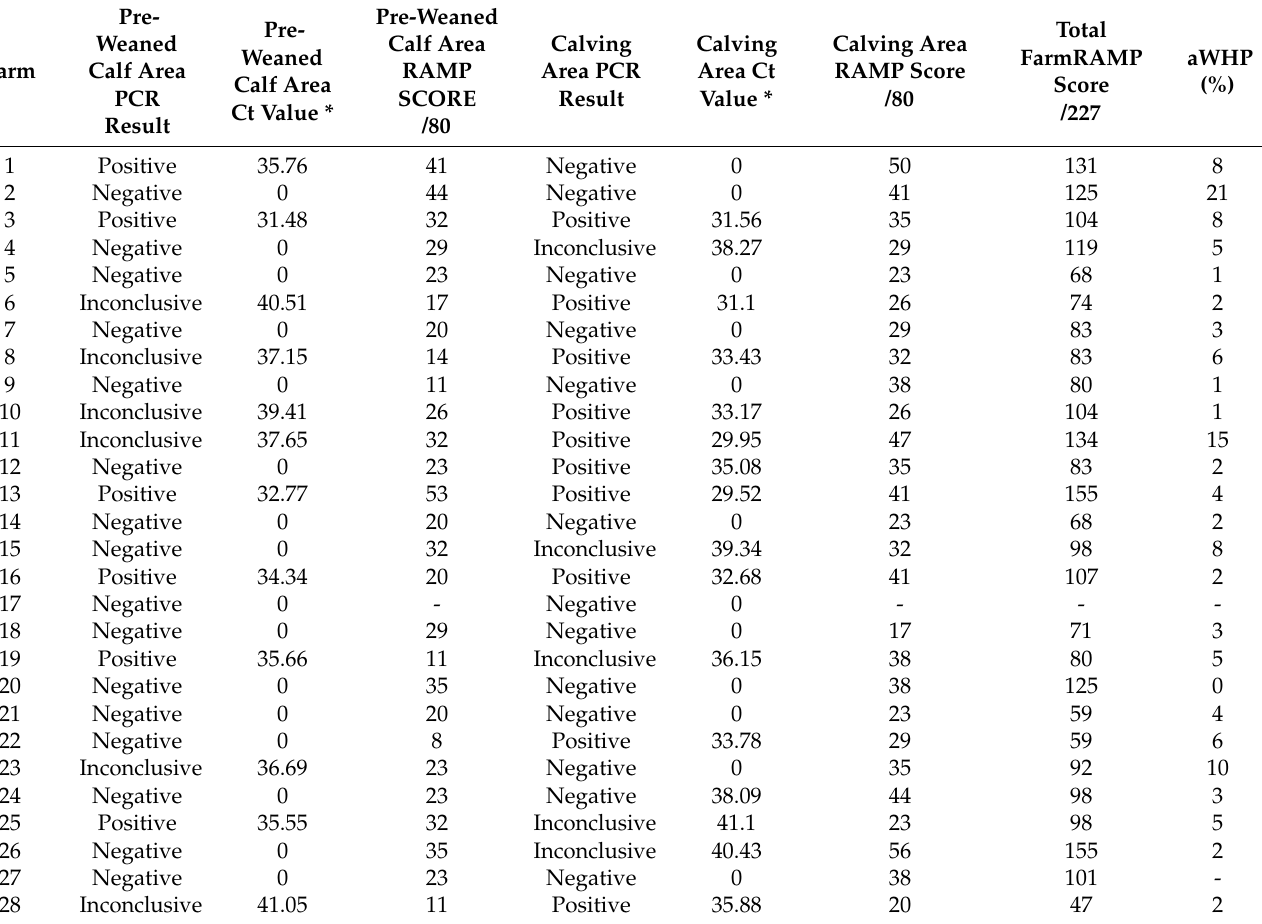
Table 1. Summary of PCR results, RAMP scores and apparent within-herd prevalence (aWHP) for 28 study